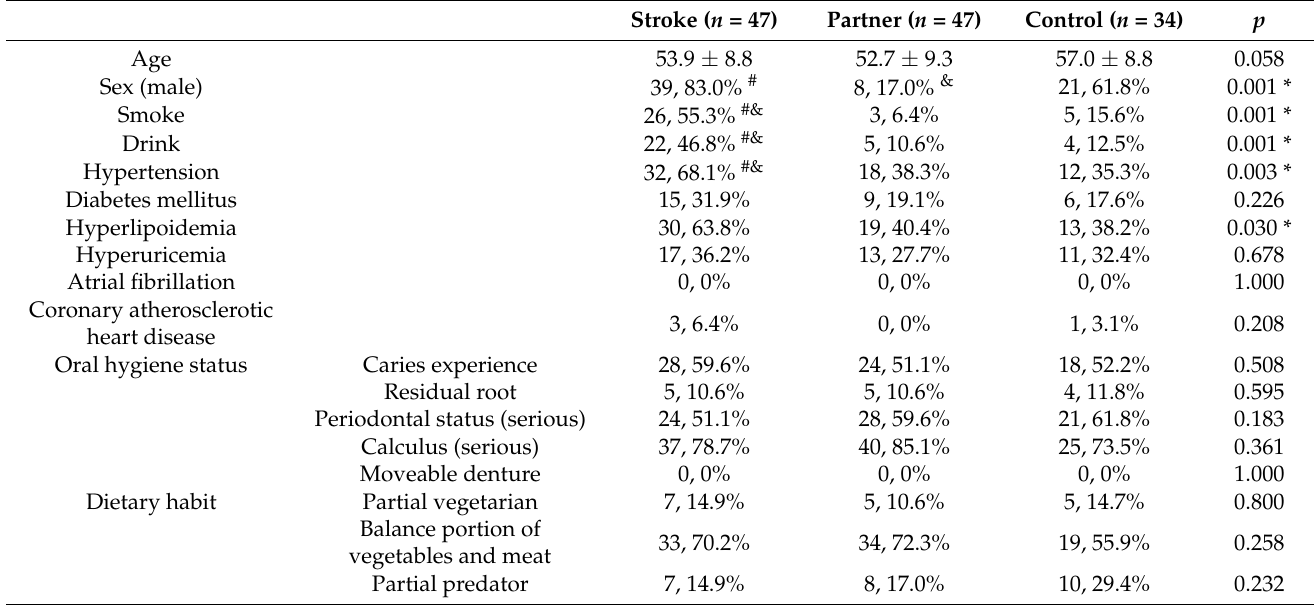
Figure 1. Flowchart of the study. In the beginning when the stroke patients were hospitalized, 73 patients were recruited for our study. At the 3-month follow-up, 9 patients dropped out of the study, samples from 8 patients could not be obtained, 4 patients died, and 5 samples were excluded due to low sequence reads. A total of 128 participants were recruited for the study, including 47 stroke patients and their respective partners and 34 controls. Table 1. Characteristics of the study participants.